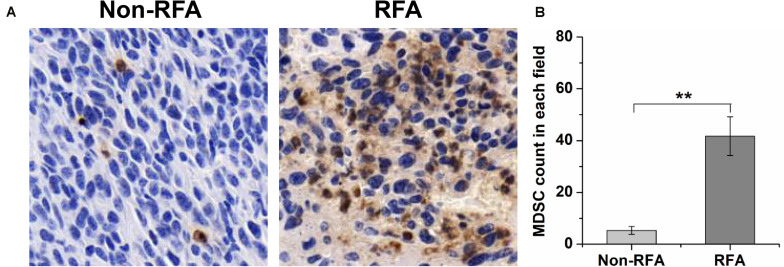
At 8 days after RFA, tumors were taken out and sectioned, and the Gr-1 staining was performed to analyze MDSC infiltration. (A) the representative plots about tumor-infiltrating MDSCs before or after RFA. (B) The quantitative analysis showed that the percentage of Gr-1 positive cells at 8 days after RFA was 10.4-fold higher than that before RFA (***P < 0.01).